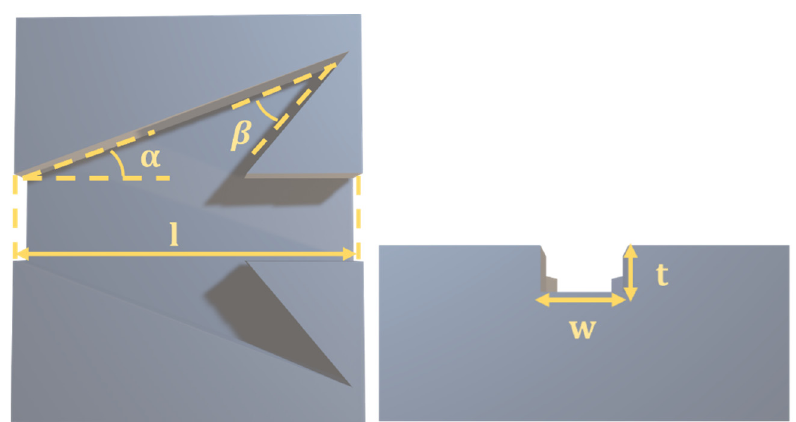
Figure 1. The design parameters of a 3D dart-shaped model